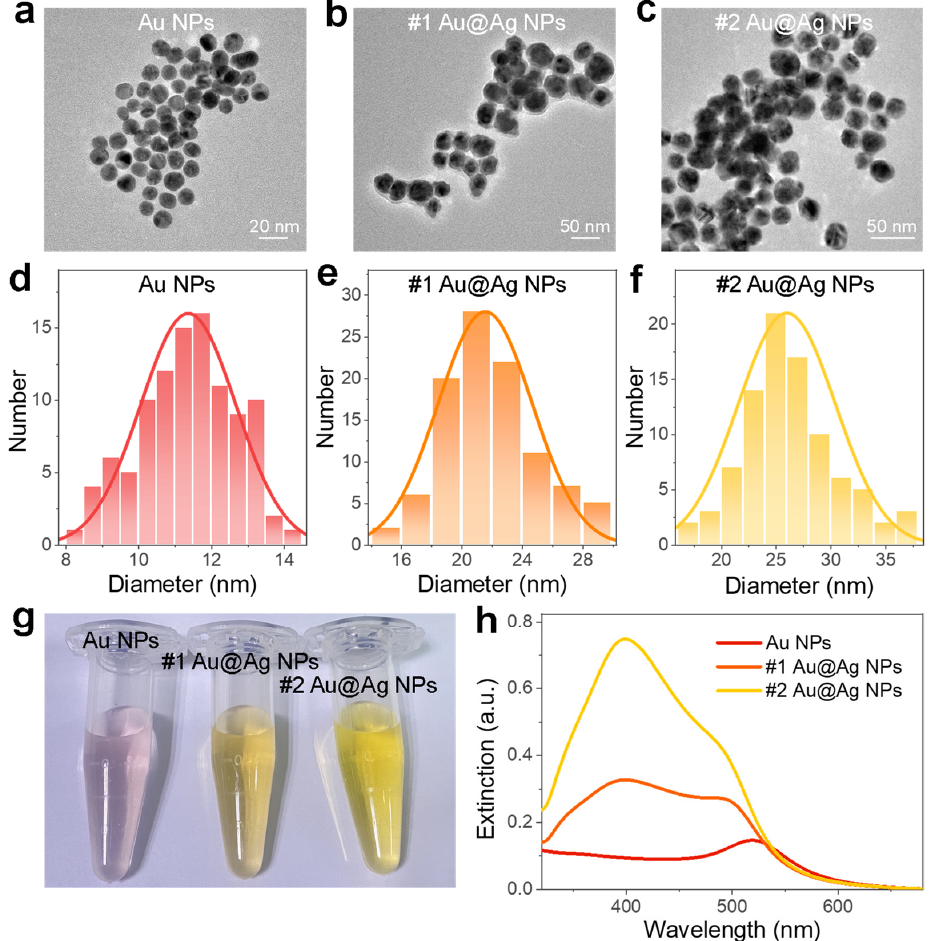
Figure 1. Morphology and optical properties of the Au NPs and Au@Ag NPs. ( a – c ) TEM images of the Au NPs and Au@Ag NPs with thin (#1) and thick (#2) shells. ( d – f ) Corresponding histograms of the size of the NPs in ( a – c ). ( g ) Photograph and ( h ) UV-Vis extinction spectra of the Au NPs and Au@Ag NPs.